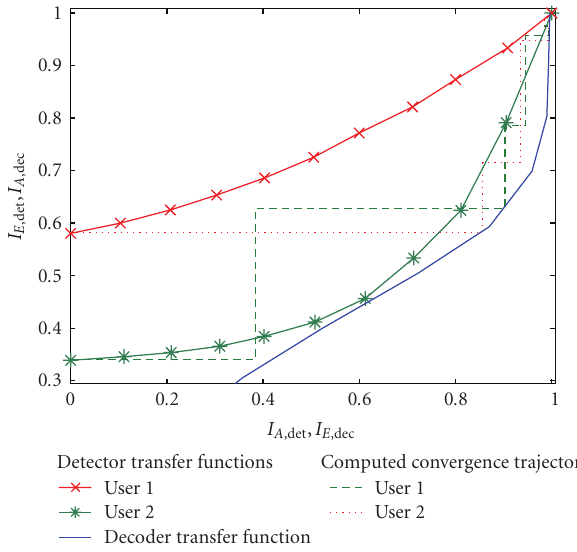
Figure 4: EXIT chart for two-coordinated users and one external interferer.